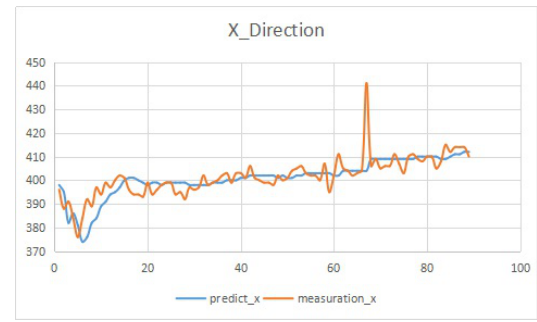
Figure 12: X coordinate of predicted point and measured value